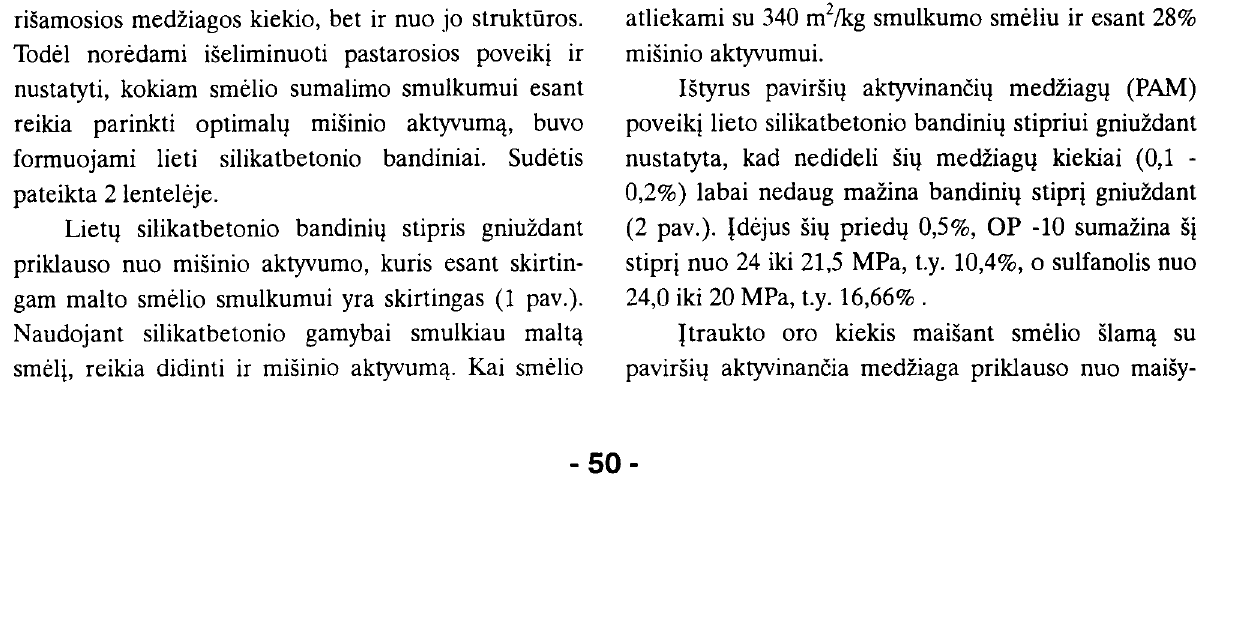
Fig 1. Cast silicate concrete sample compression strength dependency on mixture activity, at milled sand fineness, m 2 /kg: 1 - 130, 2- 340, 3- 500 Toliau didinant misinio aktyvumq, bandiniq stipris gniuzdant pradeda mazeti ( esant risamosios medziagos pertekliui susidaro aukstesnio bazingumo kalcio hidrosilikatai, be to, misinys perkaista). Apiben drinus pateiktus grafikus galima teigti, kad lengviems akytojo silikatbetonio gaminiams racionalu naudoti smelj, kurio savitasis pavirsius butq 300-350 m 2 /kg, o misinio aktyvumas 26 - 28%. Tolesni bandymai